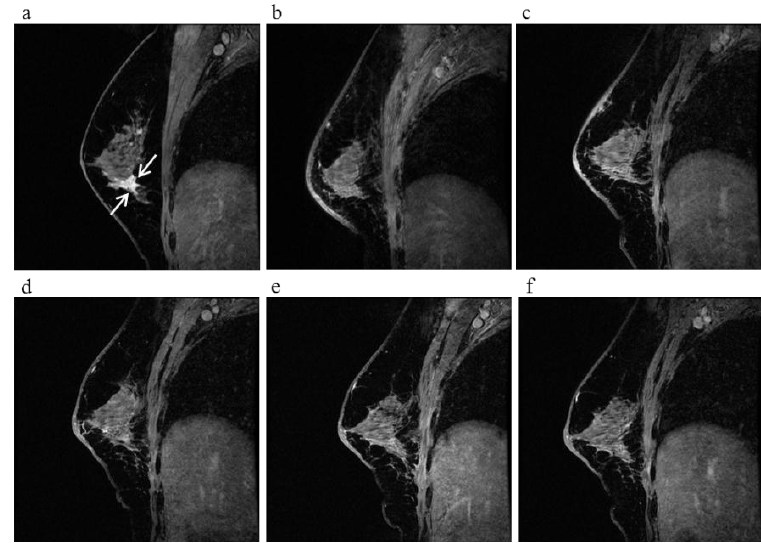
Figure 5. A 60-year-old female (case 4 in Tables 1-3) with right breast cancer (cT1cN0M0). CE breast MRI ( a ) revealed a breast tumor before KORTUC II therapy, the region of tumor was 18 mm (arrows); After KORTUC II, no recurrence was identified on CE breast MRI (( b ): 5 month; ( c ): 17 month; ( d ): 29 month; ( e ): 41 months; ( f ): 53 months).